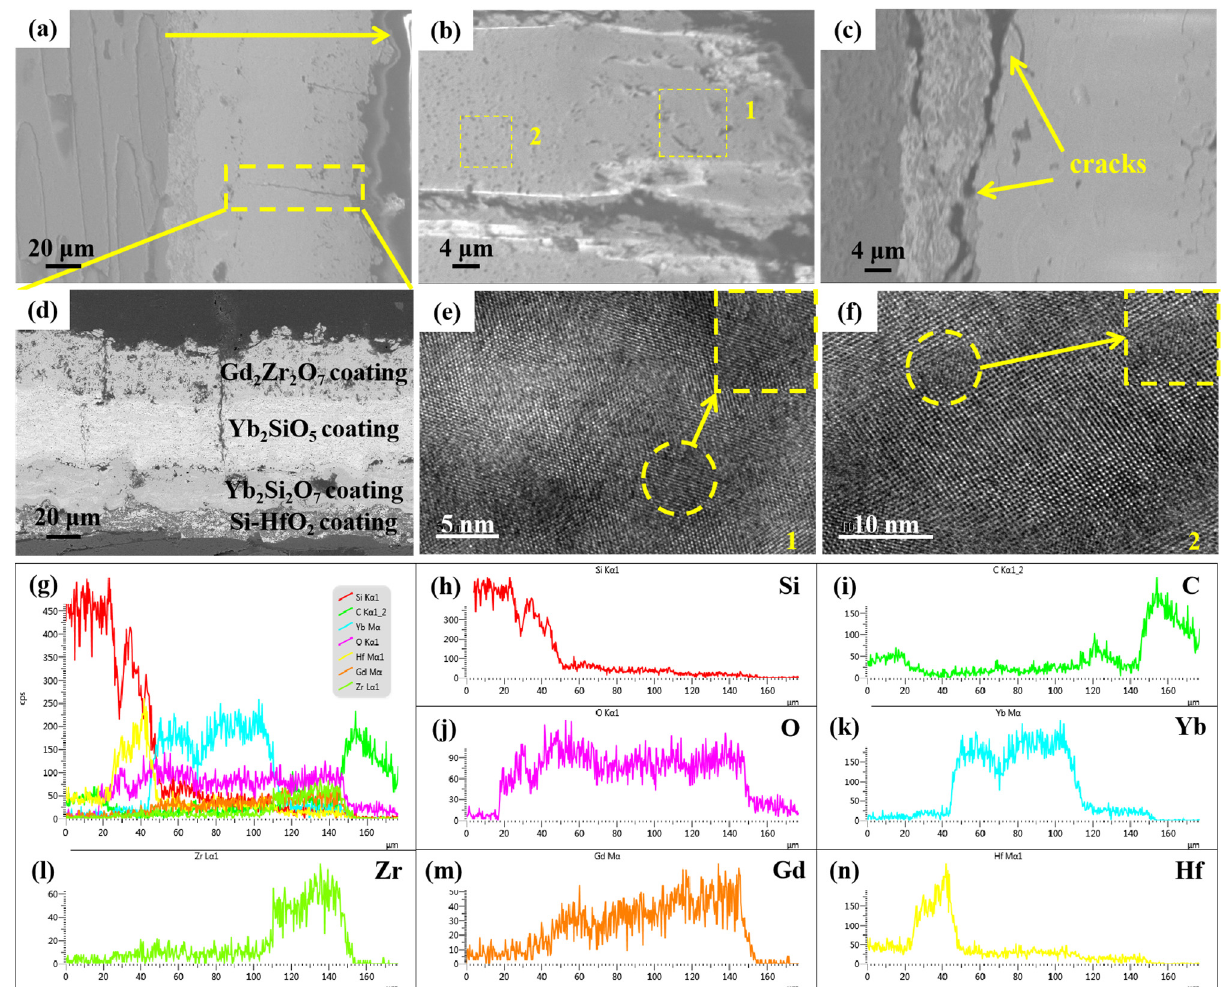
Figure 10. Micromorphology and phase analysis after water quenching: ( a ) cross-section; ( b ) TEM image of cracks in Gd 2 Zr 2 O 7 coatings; ( c ) TEM image of cracks in SiC/C/Si–HfO 2 interface; ( d ) crack enlargement of ( a ); ( e ) dislocation defect in the Gd 2 Zr 2 O 7 coating at area marked1 in ( b ); ( f ) dislocation defect in the Yb 2 SiO 5 coating at area marked 2 in ( b ). Composition distribution of T/EBC S coatings cross section after water quenching: ( g ) all elements; ( h ) Si; ( i ) C; ( j ) O; ( k ) Yb; ( l ) Zr; ( m ) Gd; ( n ) Hf.